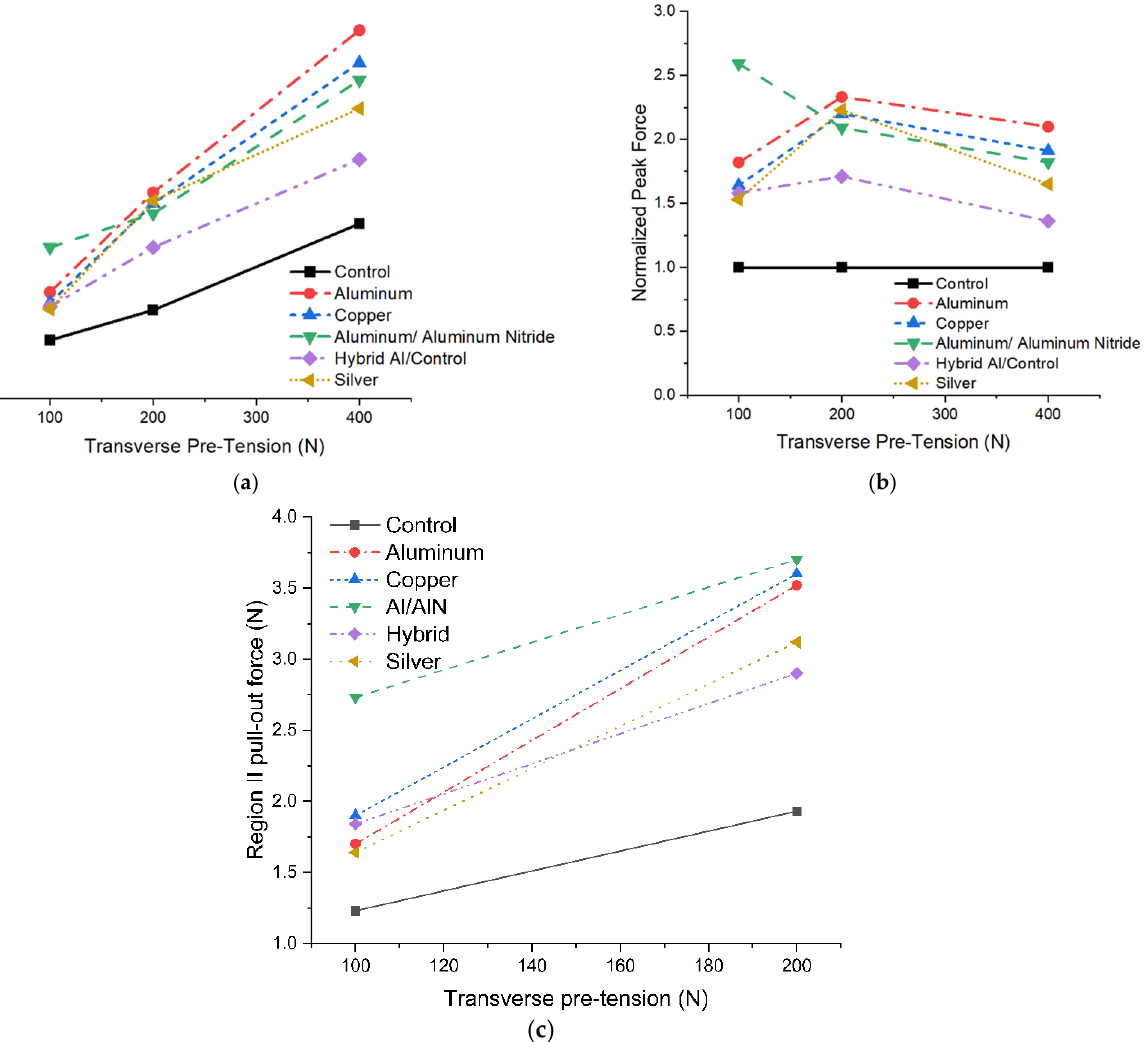
Figure 10. Effect of transverse pre-tension on ( a ) peak pull-out force ( b ) normalized peak pull-out force ( c ) Region II yarn pull-out translation force.